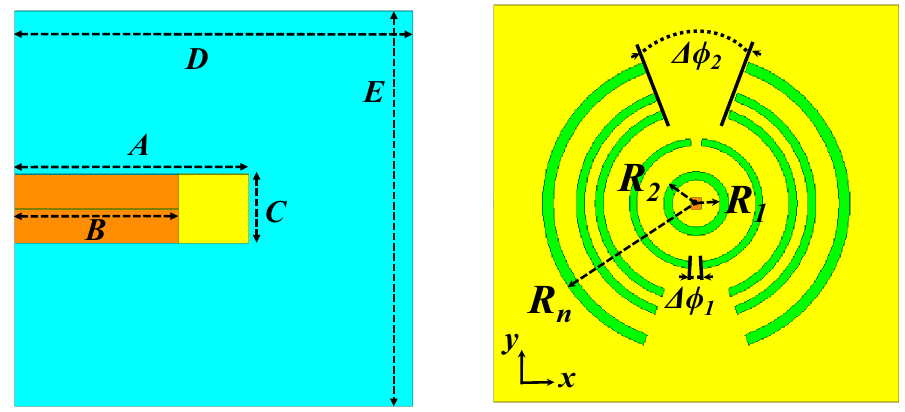
Figure 22. Detailed view for Fig. 21, right (top-view), and left (bottom-view).